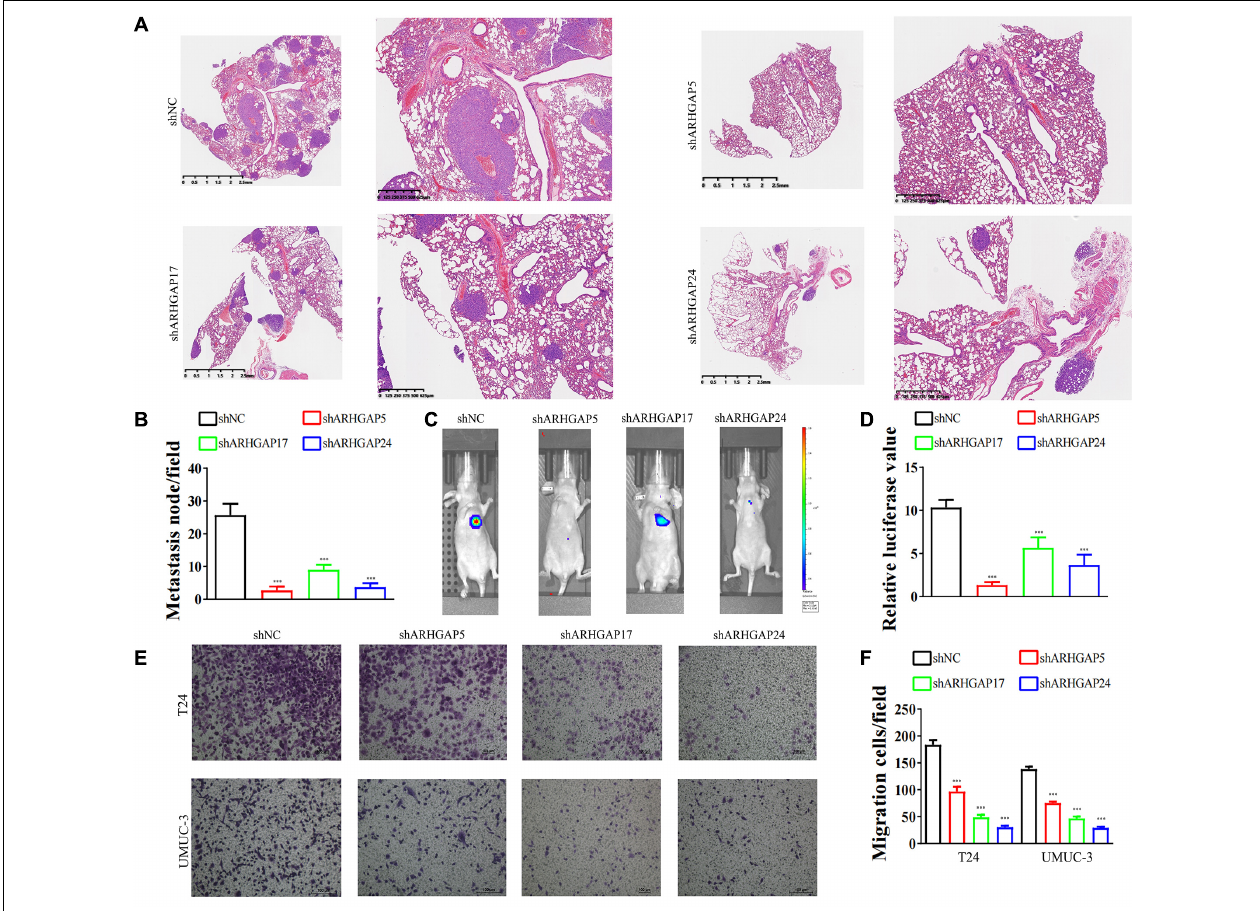
FIGURE 6 | Knockdown of ARHGAP5, ARHGAP17, and ARHGAP24 suppressed the metastasis and migration of BC cell in vivo and in vitro . (A,B) Representative hematoxylin and eosin-stained taken from shNC-T24 and shARHGAP5, ARHGAP17, and ARHGAP24-T24-bearing mice (*** p < 0.001 versus shNC). (C,D) Bioluminescence imaging in mice T24 metastasis model and knockdown ARHGAP5, ARHGAP17, and ARHGAP24 T24 cell metastasis model (*** p < 0.001 versus shNC). (E,F) Transwell assay showed that ARHGAP5, ARHGAP17, and ARHGAP24 knockdown hindered migration of T24 and UM-UC-3 (*** p < 0.001 versus